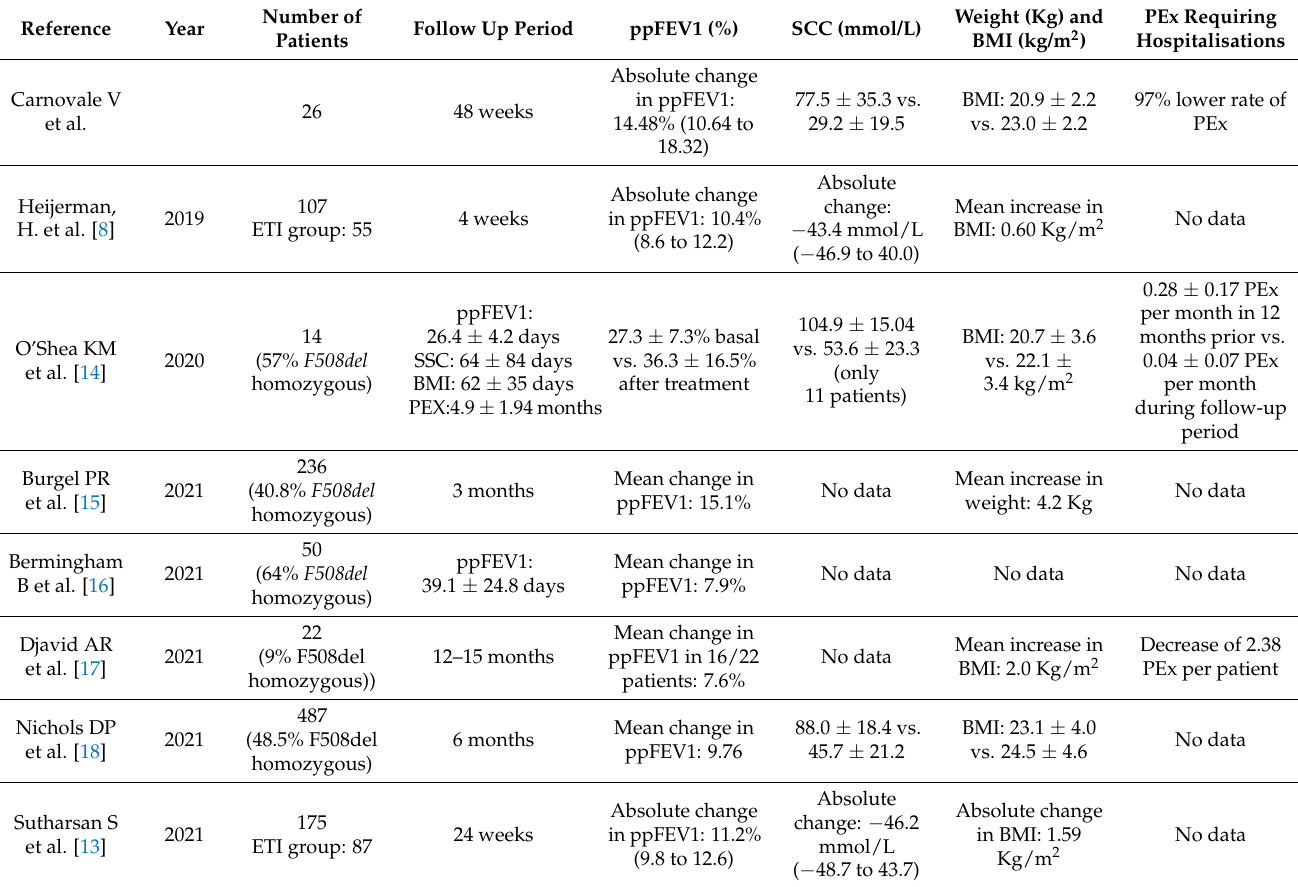
Table 4. Comparison of the main results of this study with previous